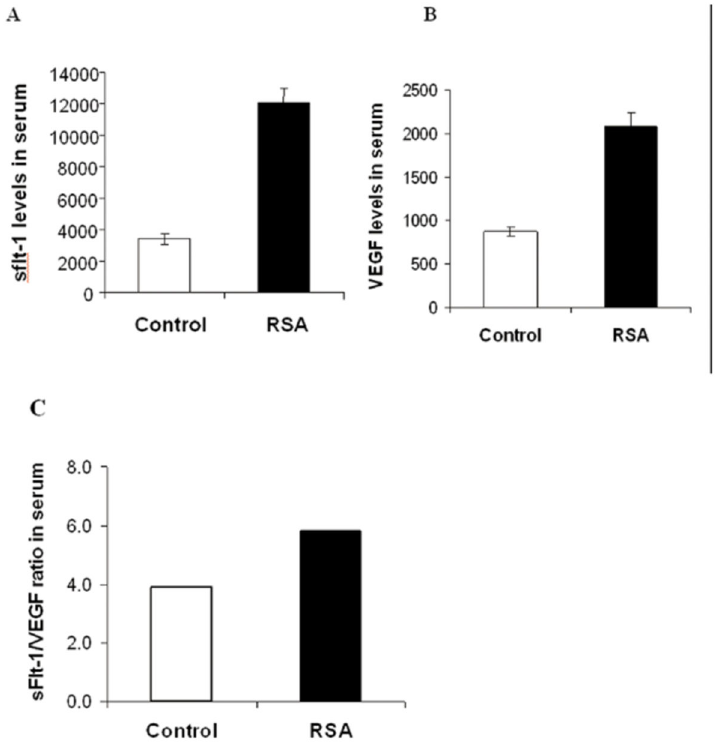
Figure 2. Levels of serum VEGF and sFlt-1 in RSA patients and normal pregnancy women. ( A ) The levels of sFlt-1 in the RSA group were significantly higher than in the control group ( p <0.0001). ( B ) The levels of VEGF in the RSA group were significantly higher than in the control group ( p <0.0001). ( C ) The ratio of sFlt-1/VEGF in serum. doi: stained cells (trophoblastic and interstitial cells) in all fields counted (10 fields for each specimen). Immunohistochemical expression data are expressed as mean ± standard error (mean ± sem) values.